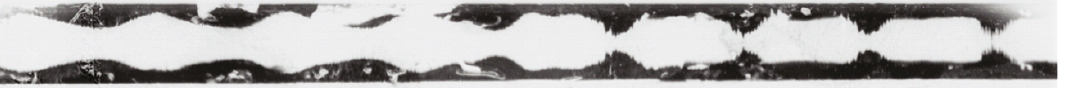
Figure 6: A heavily corrupted soundtrack (fungus or